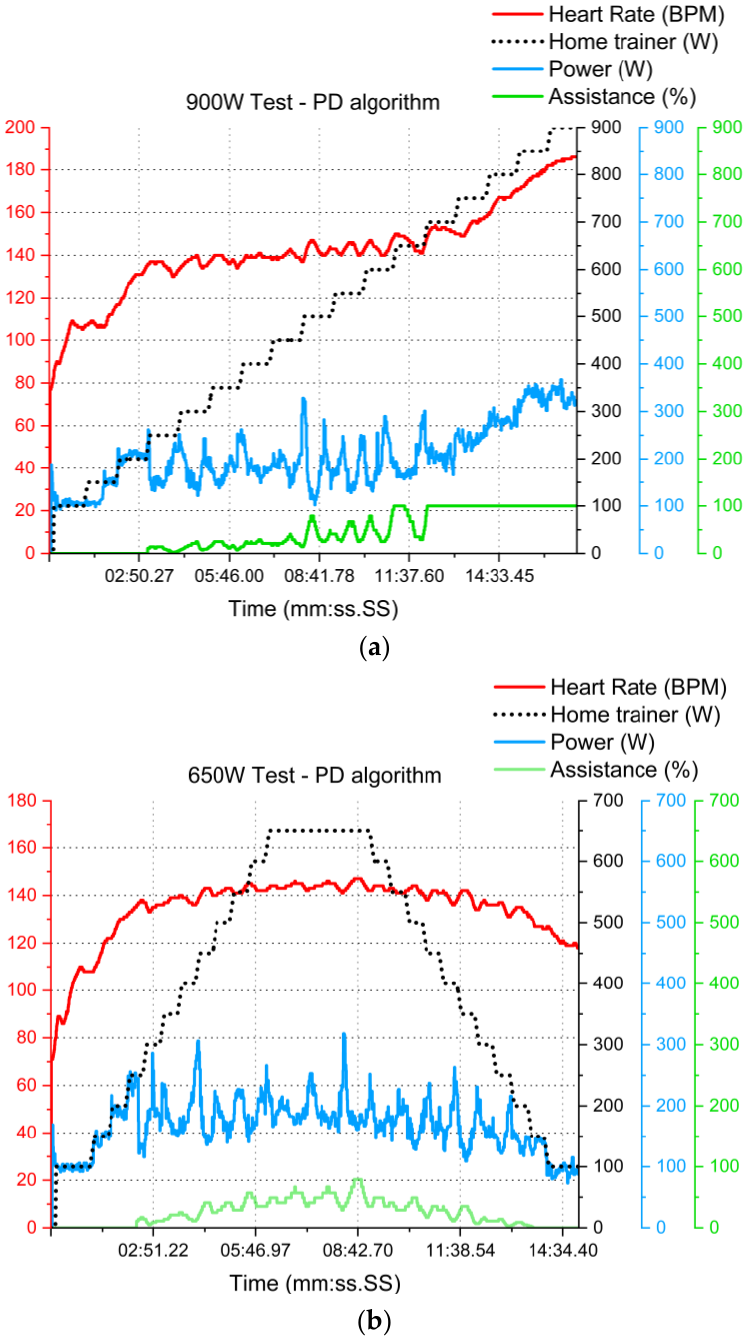
Figure 11. Example (N = 1) of PD algorithm curve response tests for ( a ) 900 W and ( b ) 650 W. The tester obtained a mean of 142 ± 21 BPM, with a maximum value of 187 BPM. If the average heart rate is only calculated for the data recorded before 700 W, then the rider’s heart rate was 132 ± 16 BPM, with a maximum of 150 BPM. Across the group, the mean was 137 ± 7 BPM; before the 700 W cap, the average was 131 ± 4 BPM (Table 5). Table 5. Overall results using the PD algorithm.